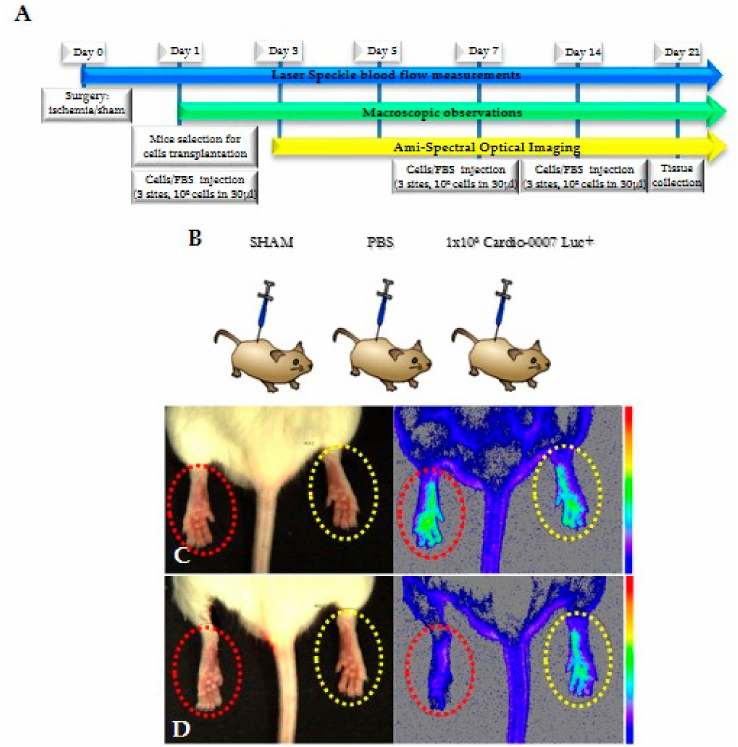
Figure 3. ( A , B ) The scheme of the experiment. ( C , D ) blood flow in hind limbs imaged with AMI; red circle—operated limb; yellow circle—healthy limb. Limited blood flow visible in left limb is a symptom of